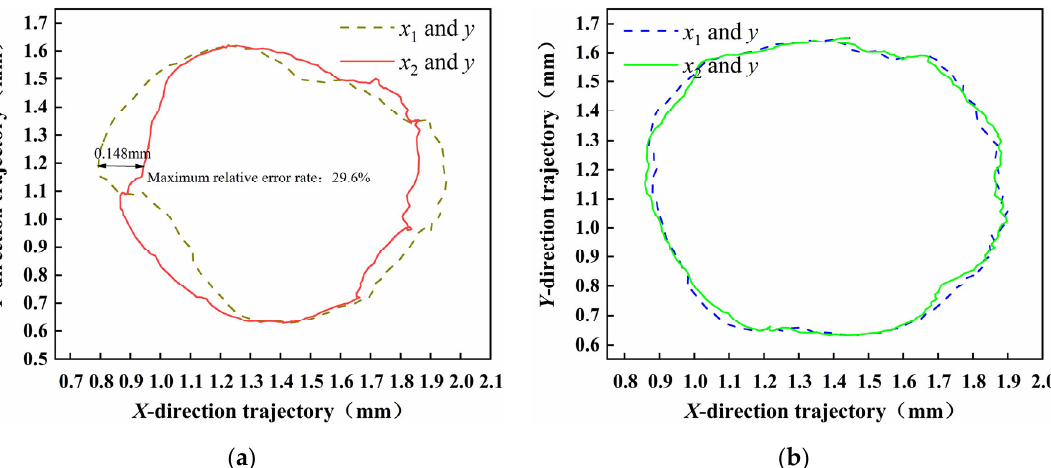
Figure 12. Trajectory tracking diagram. ( a ) Trajectory tracking under decentralized control; ( b ) Tra‑ jectory tracking under centralized control.